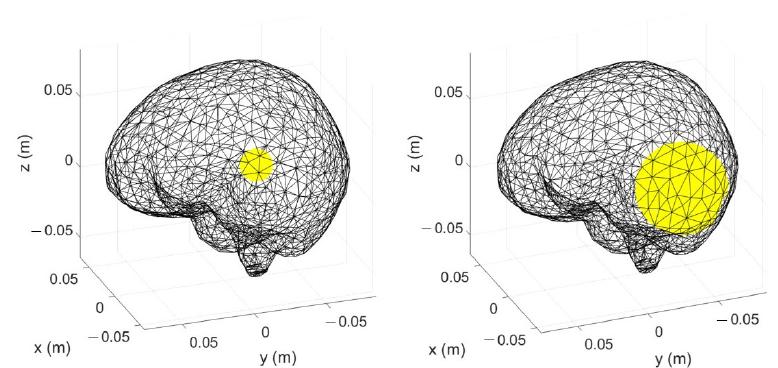
Figure 4. Discretized brain together with spherical strokes (in yellow); left: the smallest stroke size (radius = 1cm and volume = 4.2cm 3 ); right: the largest stroke size (radius = 3cm and volume = 113.1cm 3